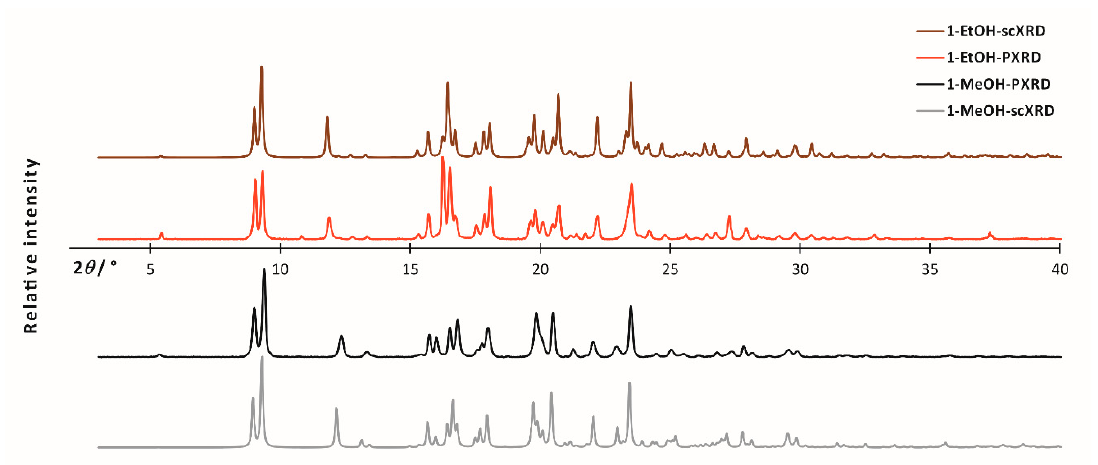
Figure 1. Experimental bulk powder X-ray diffraction patterns (black and red) and simulated powder diffraction patterns obtained from scXRD data (gray and brown) for 1-MeOH and 1-EtOH , respectively.